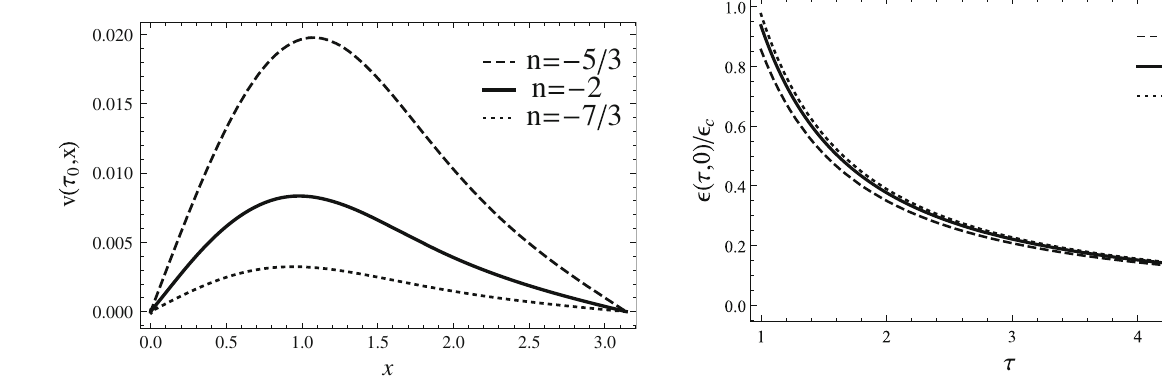
Fig. 6 Transverse velocity v(τ, x ) versus x plotted at τ = 1 fm with different values of n . The dashed, solid and dotted curves correspond to n = − 5 / 3 , − 2 and − 7 / 3, respectively